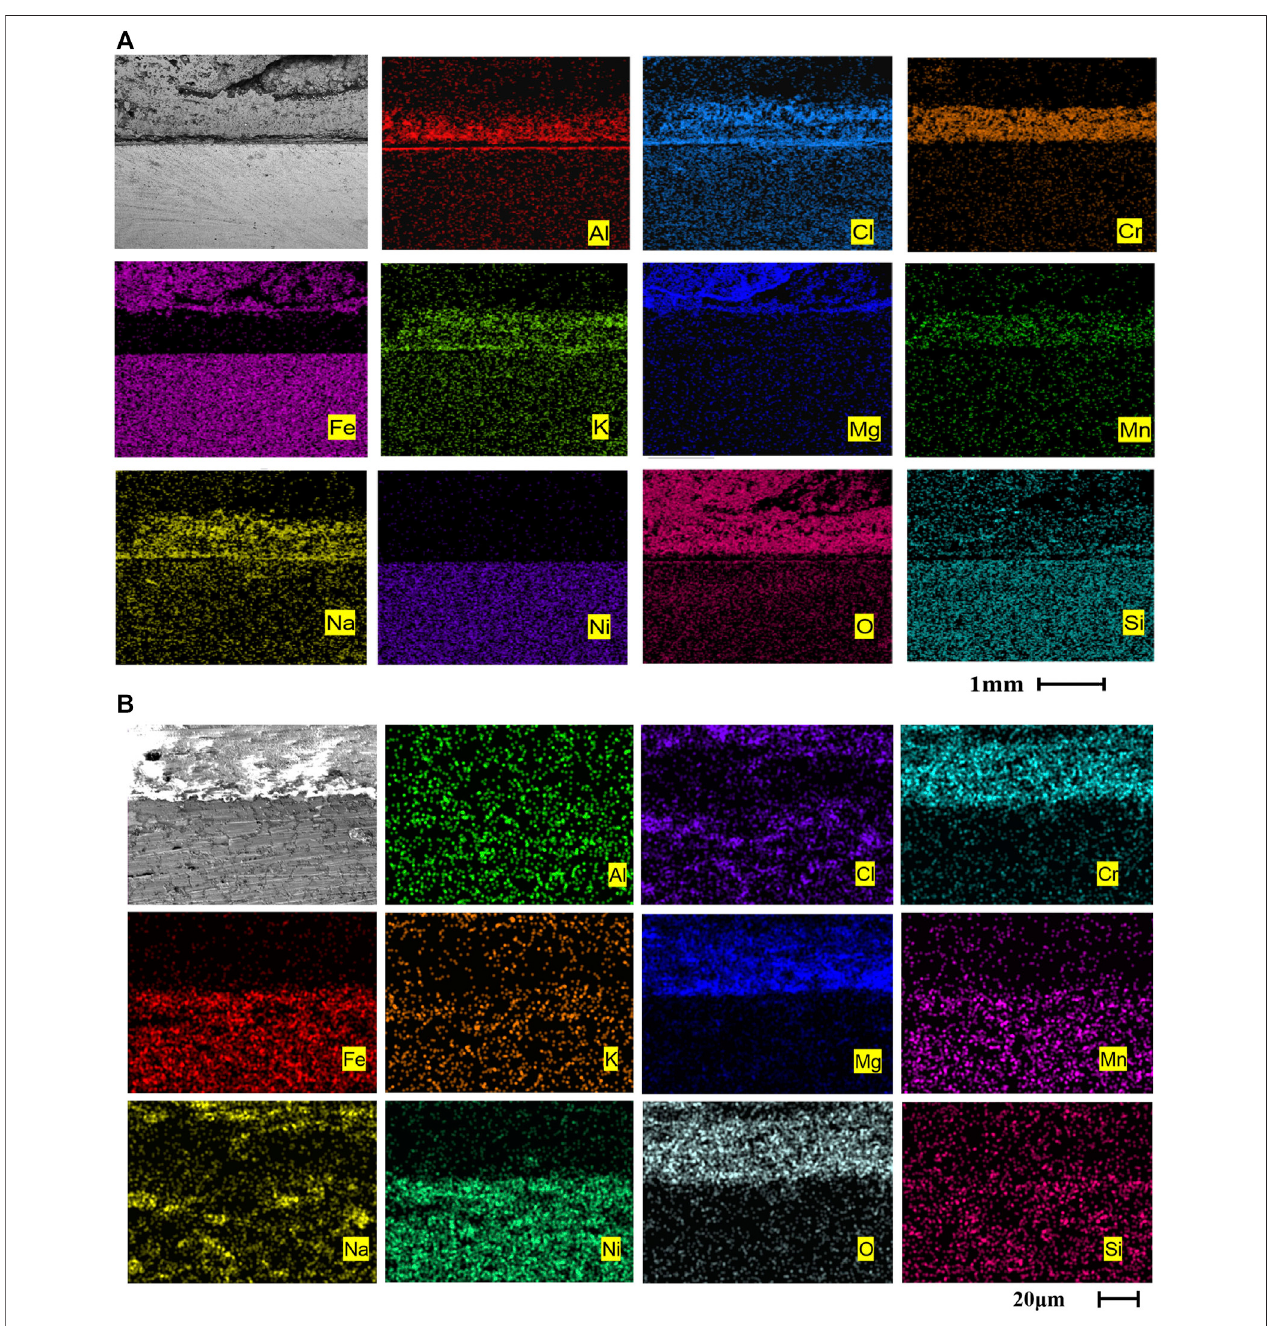
FIGURE 5 | Cross-sectional morphologies and EDS mapping of two alloys after corrosion at 800 ° C for 120 h: (A) AFA 310S, (B) commercial 310S